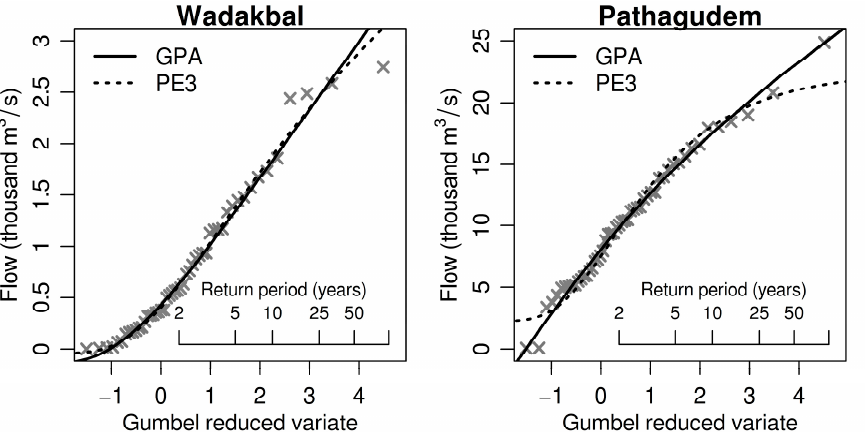
Figure 4. Growth curves associated to ( left ) Wadakbal gauging station on the Sina River, QMED = 581 m 3 /s, and ( right ) Pathagudem gauging station on the Indravathi River, QMED = 10,045 m 3 /s. Gray × symbols indicate ranked gauged AMAX flows at each station.